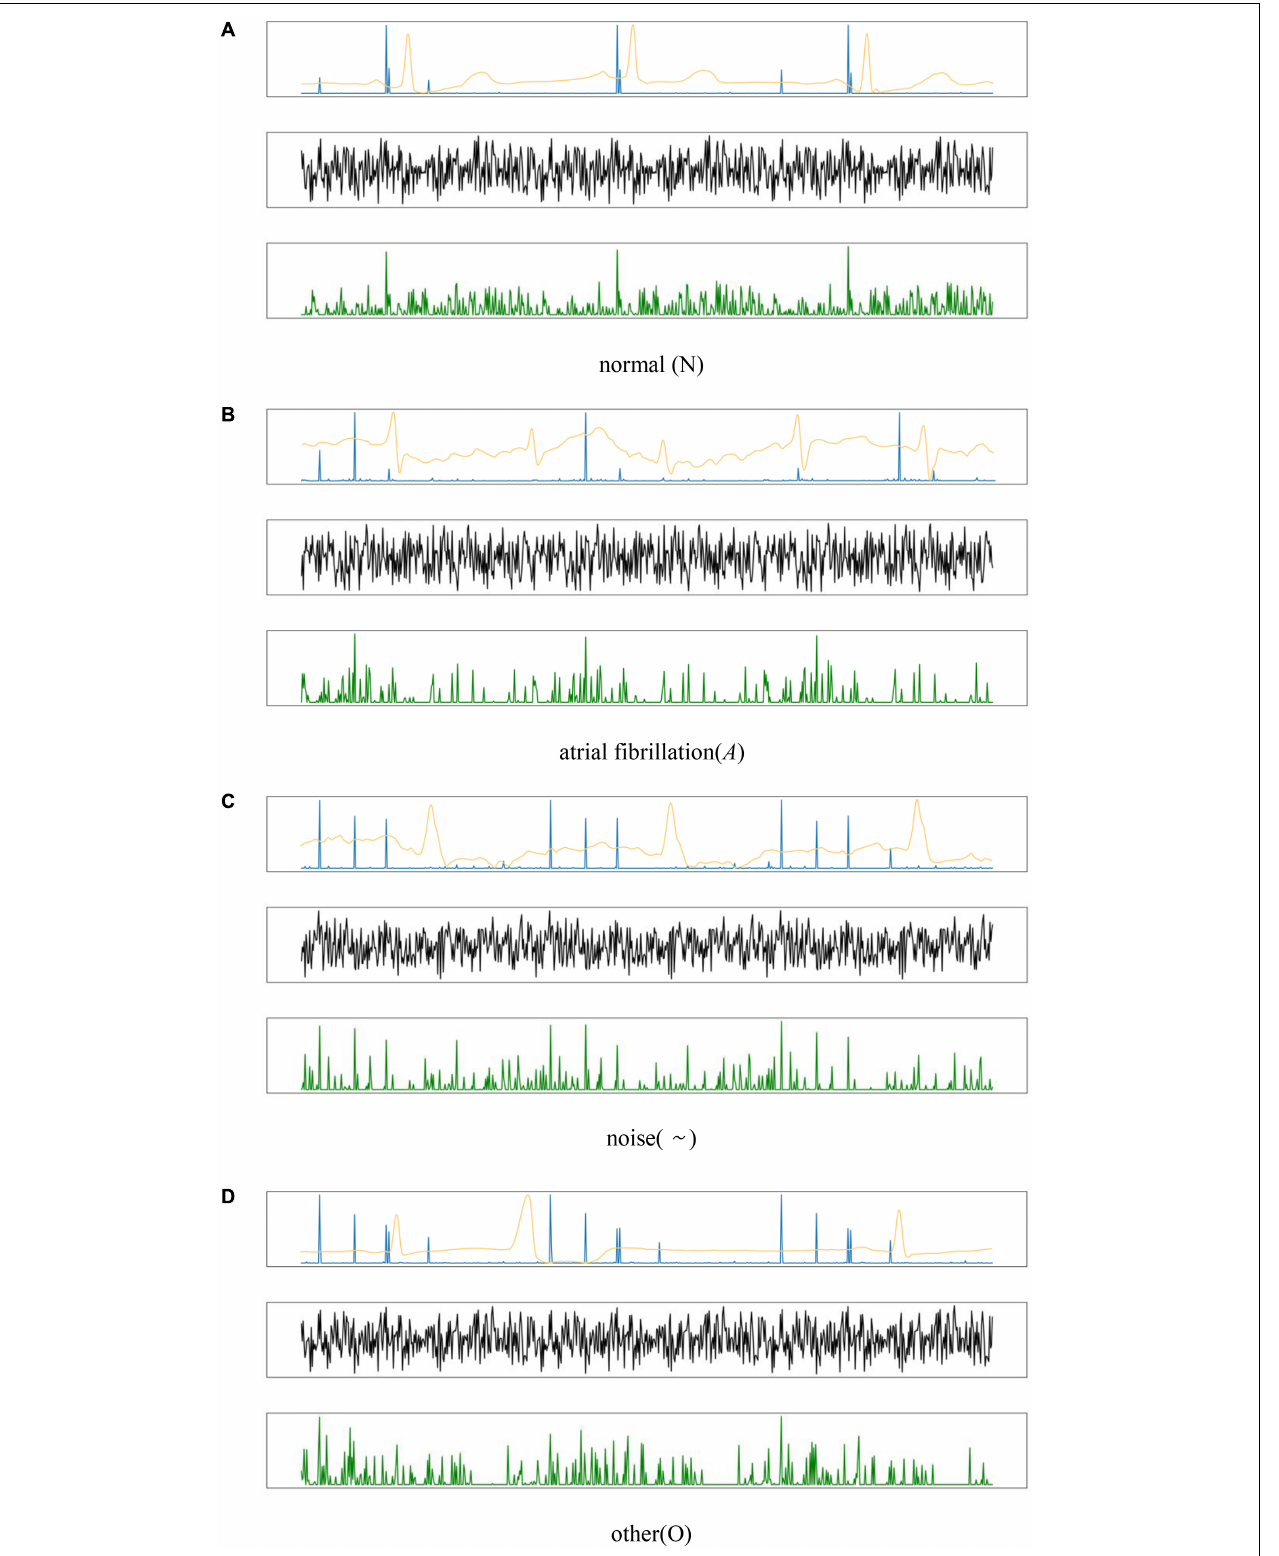
FIGURE 7 | The output of feature mapping by using the different types for four kinds ECG signals: (A) normal, (B) atrial fibrillation, (C) noise, and (D) other. The yellow line is the ECG signal, the green line is mapping of the ResNet model, the black line is the mapping of ResNet_A model, and the blue line is the mapping of HADLN